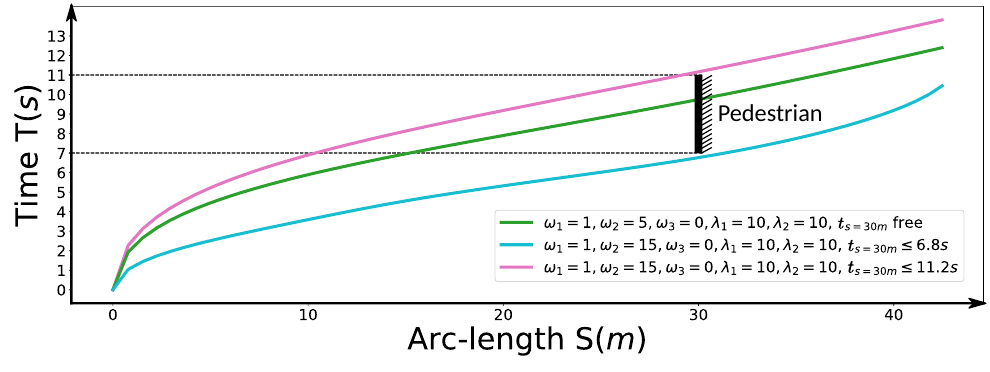
Figure 17. S-T graph for the jaywalking